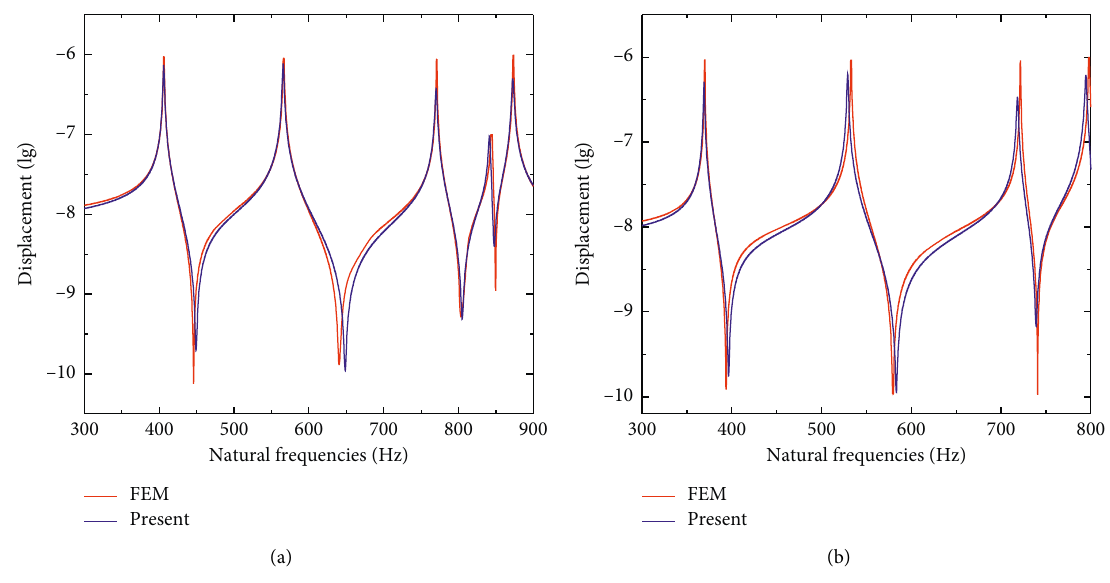
Figure 6: The comparison of vertical displacement of FG-CNTRC plate. (a) Non-stepped FG-CNTRC plate. (b) Multi-stepped FG-CNTRC plate.